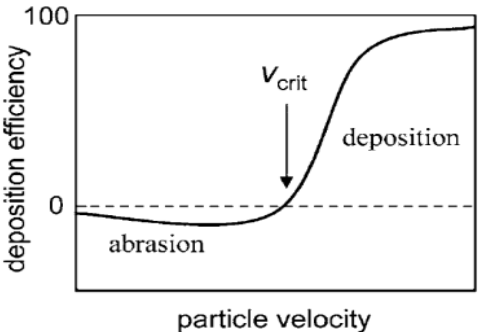
Figure 12: The effect of particle velocity on deposition efficiency (DE) in CS [7].